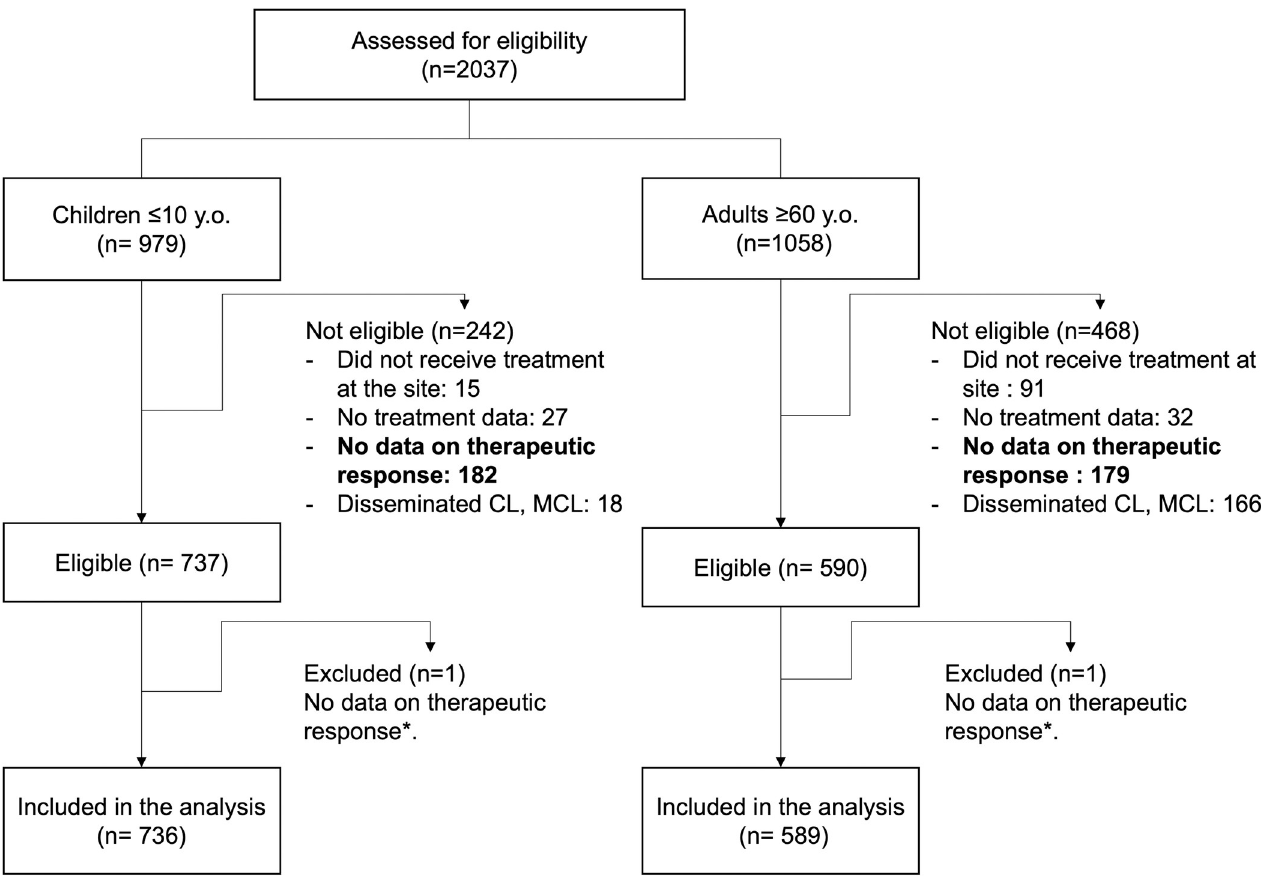
Fig 1. Screening and enrolment. � Excluded after the data cleaning and response to queries from the sites.